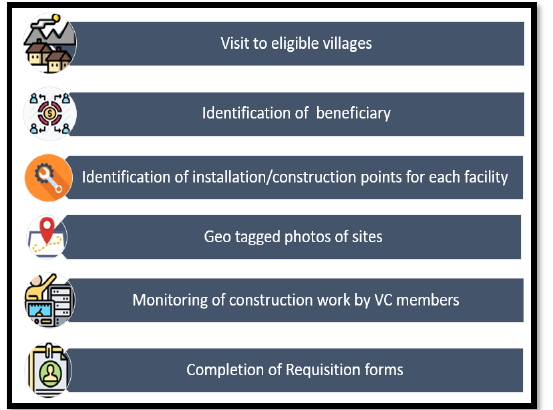
Figure 4. Summary of need assessment, prioritization, and incentive